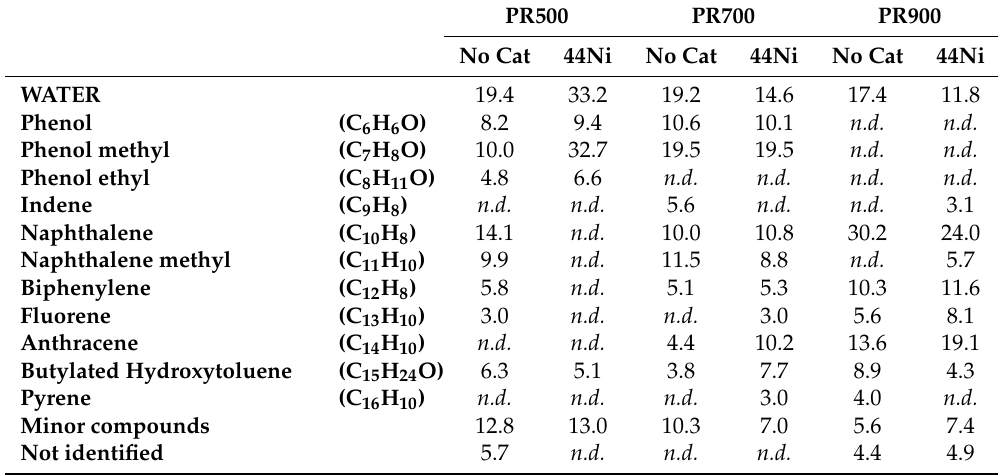
Table 6. Composition of pyrolysis liquids (%